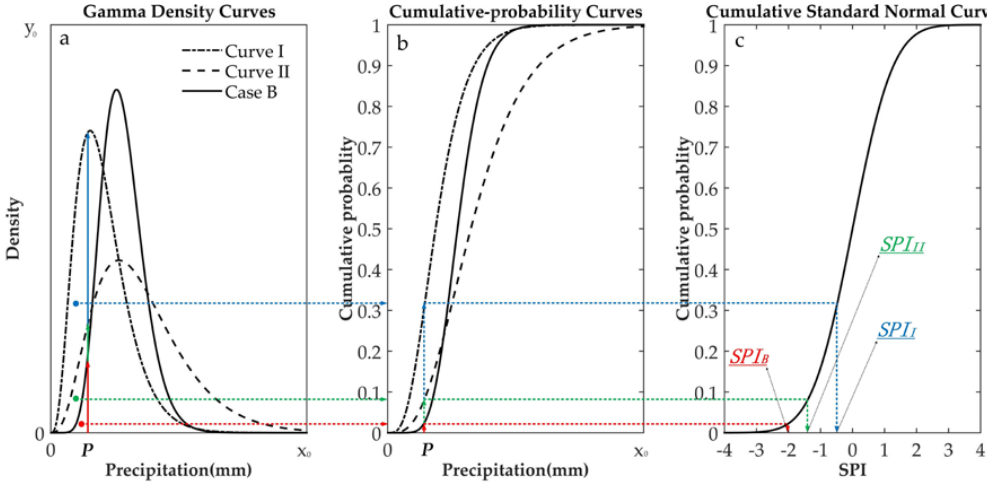
Figure 8. Explanation of transformation from precipitation density ( a ) to precipitation cumulative probability ( b ) to SPI ( c ), Curve I and Curve II represents the corresponding gamma density curves of a station with minimum mean precipitation and a station with maximum mean precipitation, respectively.